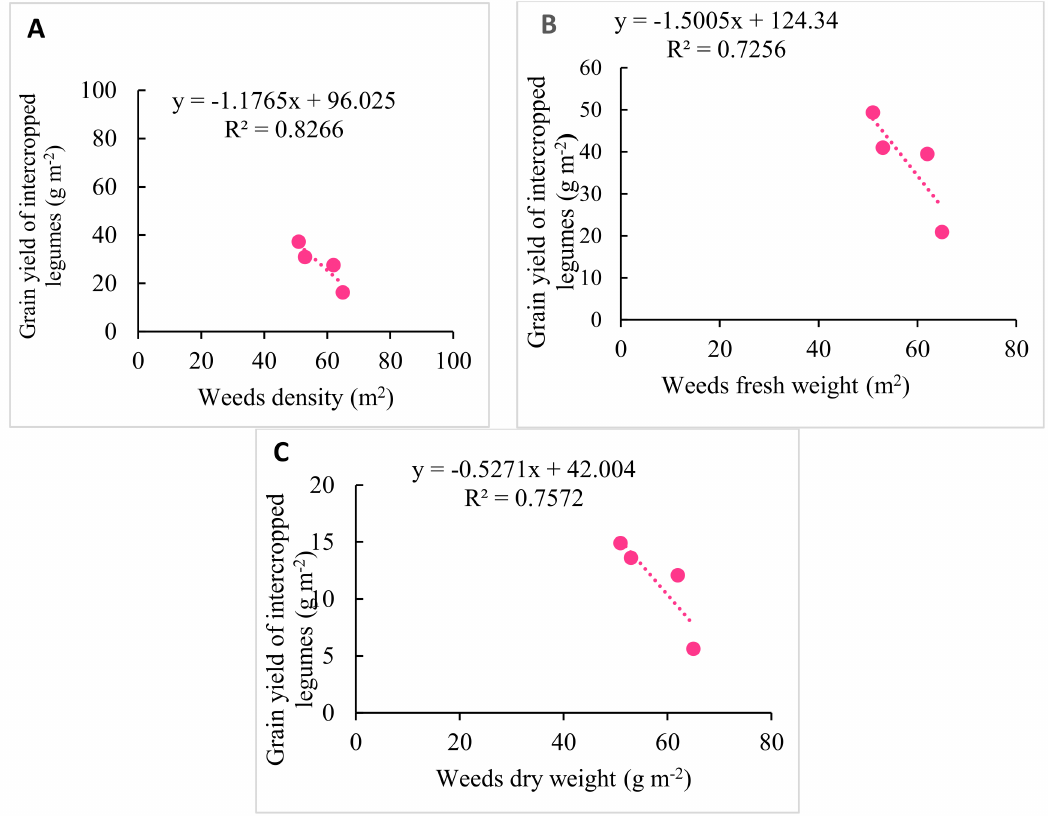
Figure 3. Interrelationship of weeds density and their fresh and dry weights with grain yield of intercropped pulses. Sole crop were excluded and mean values of following four intercropping systems have been used for correlation; T 5 = six single rows (60 cm apart) of maize with twelve double rows (20 cm) of black gram, T 6 = six single rows (60 cm apart) of maize with twelve double rows (20 cm) of green gram, T 7 = three double rows (90 cm apart) of maize with three sets of quadratic rows (20 cm apart) of black gram, T 8 = three double rows (90 cm apart) of maize with three sets of quadratic rows (20 cm apart) of green